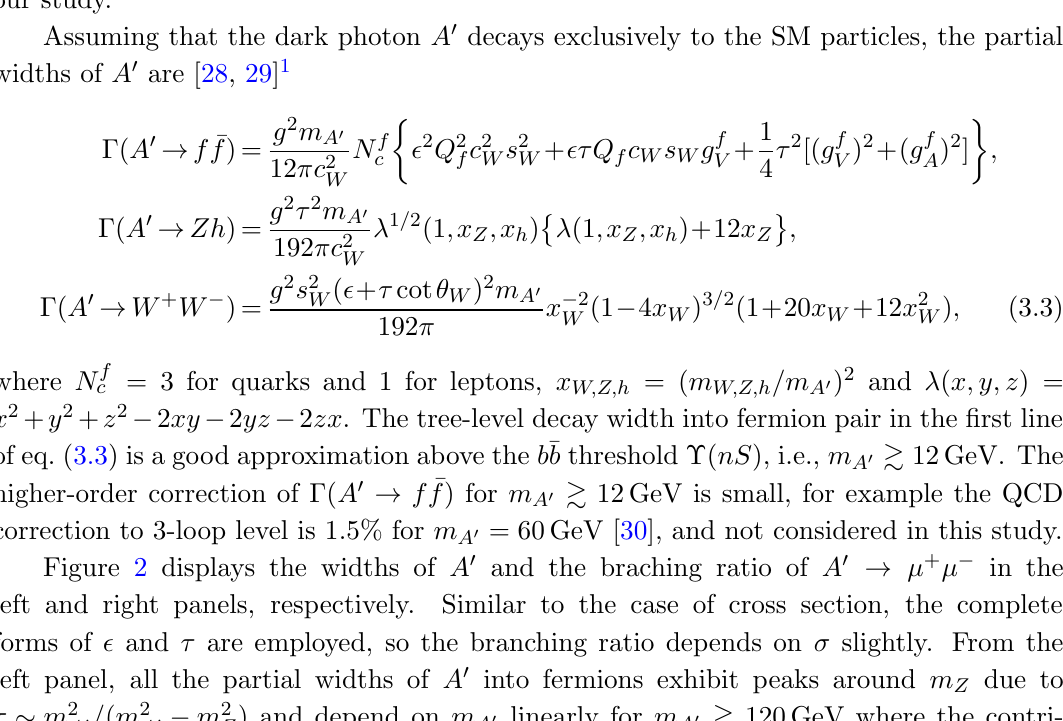
Figure 1 . Cross sections of e + e (cid:0) ! A 0 (cid:13) at and E (cid:13) > 10